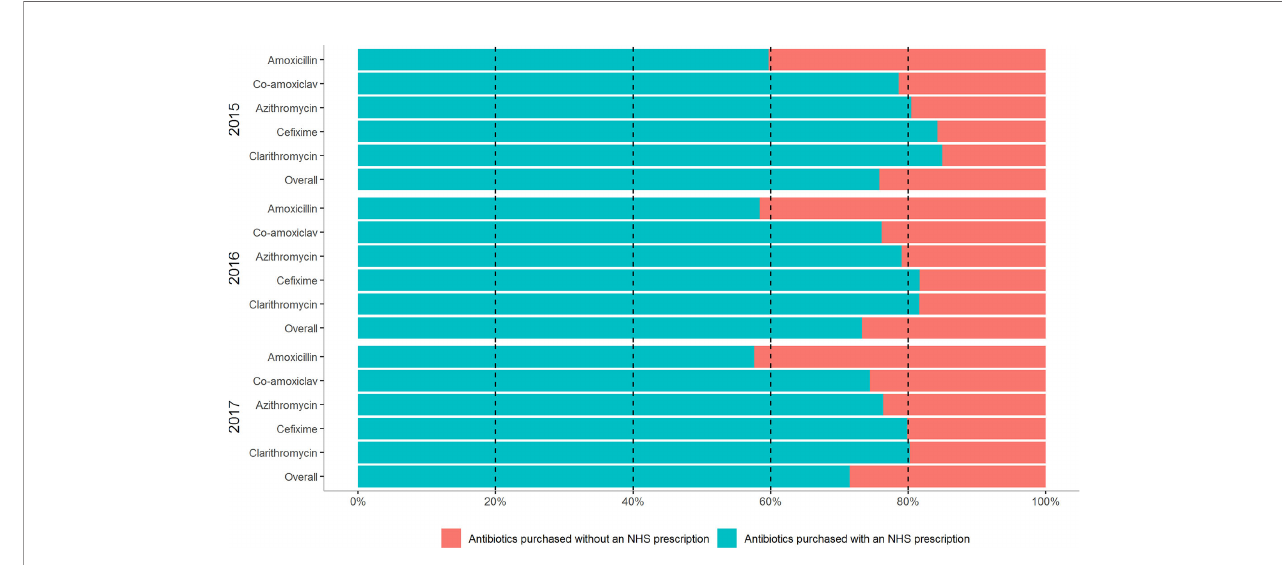
FIGURE 2 | Antibiotic purchasing trends at the national level in Italy for pediatric formulations of the top fi ve antibiotics used in children by calendar